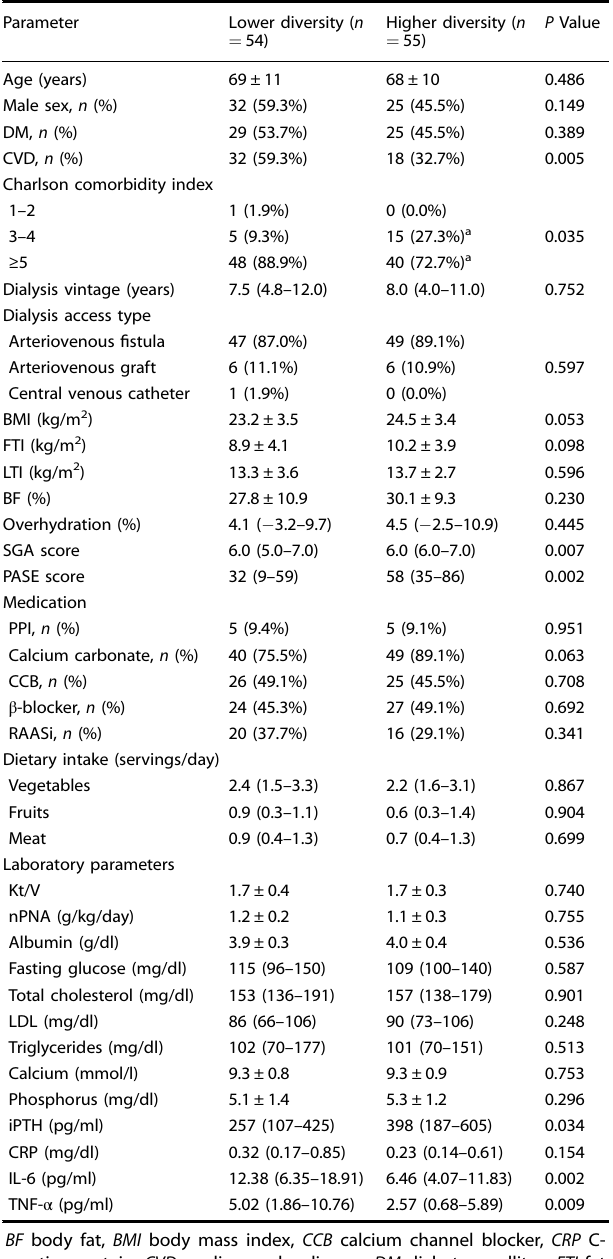
Table 1. Baseline characteristics of patients according to the median Simpson